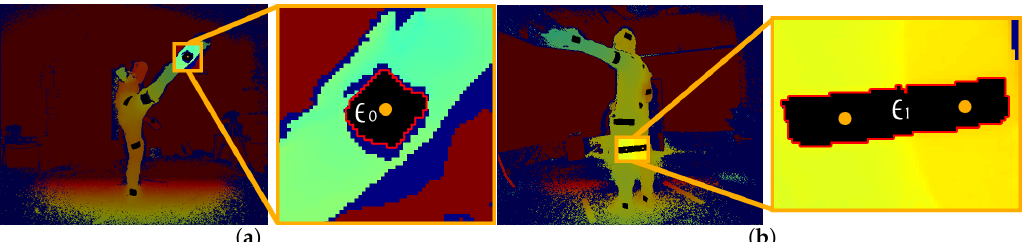
Figure 7. Contour detection (red pixels) of the reflector regions for depth estimation and 3D mapping. ( a ) Contour of single reflector region, E 0 . ( b ) Contour of multi-reflector region, E 1